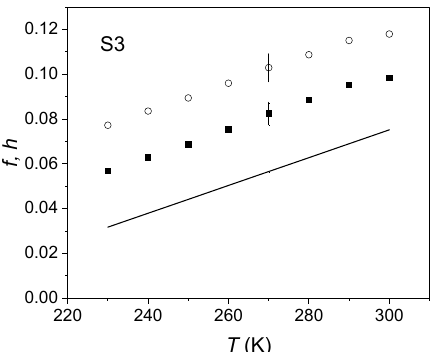
Figure 6. Free volume fraction in the elastomer S3 using the spherical approximation (circles) and in cylindrical geometry (squares). Continuous line: theoretical free volume fraction h .